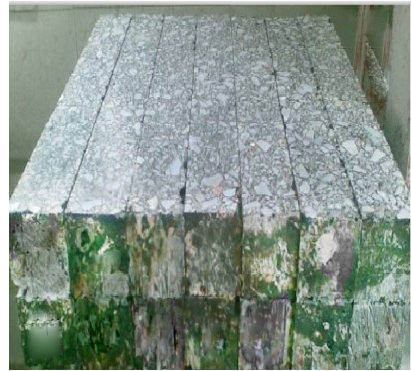
Figure 2. Boltzmann's superposition principles.